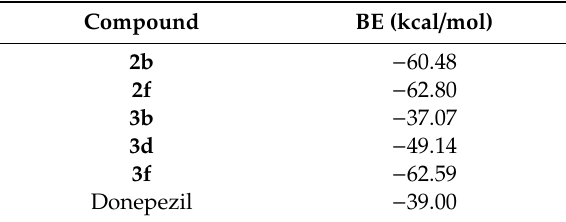
Figure 4. Docking poses of donepezil (yellow) and 2f (orange) represented with BChE (1P0I) in ribbon format ( a ). 2D plots of docking results for 2b ( b ), 2f ( c ), 3b ( d ), 3d ( e ) and 3f ( f ) into BChE including the bonding interaction. Bright green represents conventional hydrogen bonds, light green—van der Waals interactions, verylightgreencarbonhydrogenbonds, darkpink—pi–piinteractions, lightpink—pi–alkyl interactions, orange—pi–anion or pi–cation interactions and blue—halogen (fluorine) interactions. Table 8. Calculated binding energy values for 2b , 2f , 3b , 3d and 3f